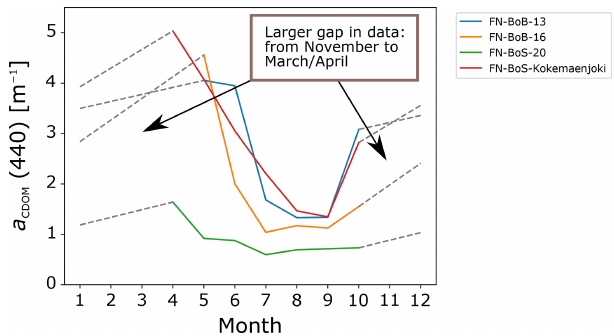
Figure 2. The aggregated monthly values of a CDOM based on EO data (S2 and C2RCC V1) for four ERGOM input locations on the western coast of Finland. Location of the rivers is shown in Fig.